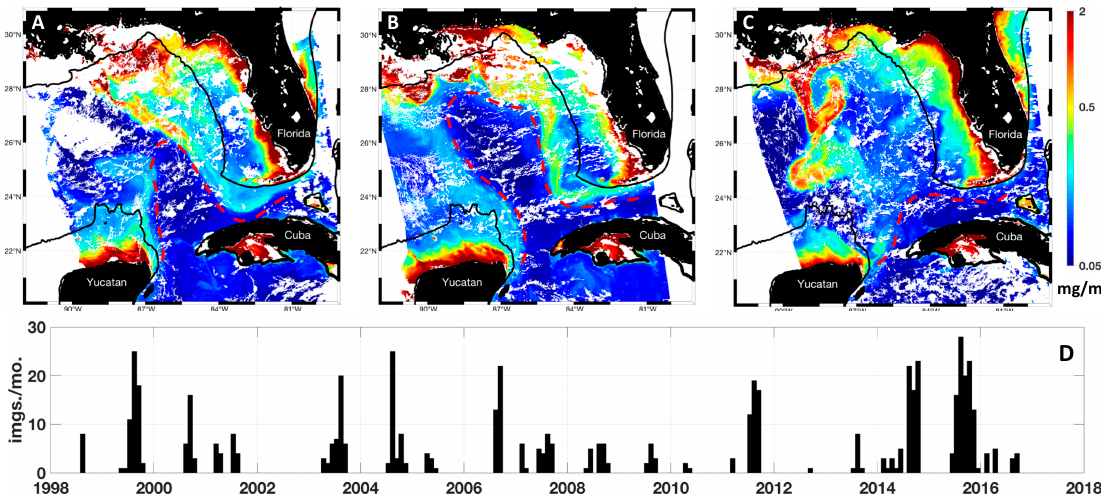
Figure 4. MODIS-Aqua chlorophyll-a images showing transport of water from the Mississippi Delta to the Florida Keys. From left, images are ( A ) 5 August 2011, ( B ) 22 July 2015, and ( C ) 18 August 2016. ( D ) Time series of the number of images per month which showed evidence of the transport of Mississippi River water to the Florida Straits. Solid black line represents the 100 m isobath. Dashed red line represents the contour of the Loop Current estimated from altimetry derived MADT data for the date of the corresponding satellite